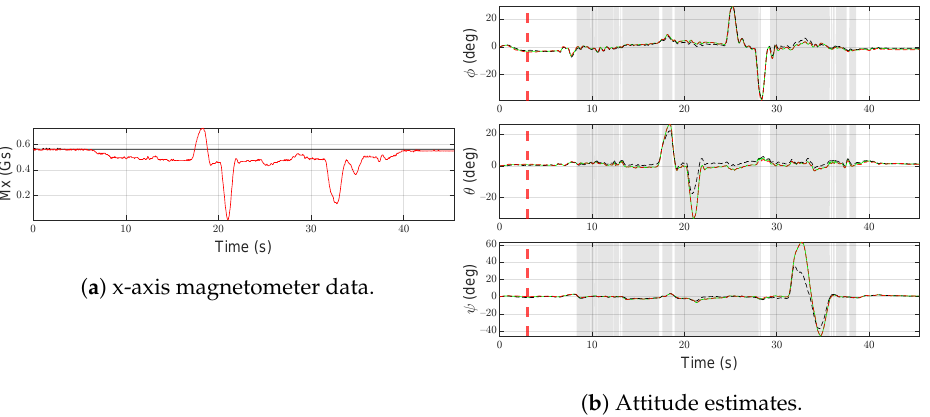
Figure 9. Scenario F3. Black lines denote measurements/estimates from IMU-1, red lines are for measurements/estimates from IMU-2. Green lines represent the output of the system, gray areas highlight the time interval in which the SFDI algorithm is in the fault state. Vertical red dashed lines denote the time instants when the fault occurs and